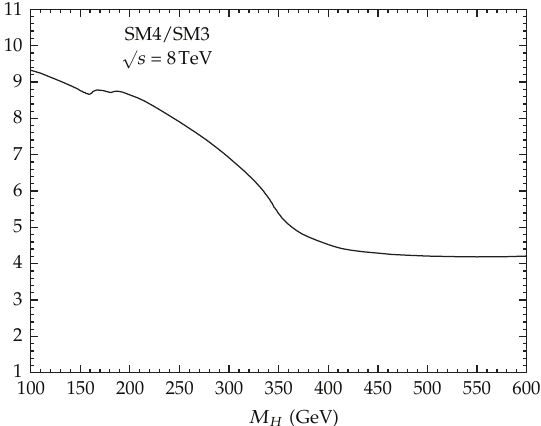
Figure 5: Comparison of gluon fusion cross-section within the SM4 and the standard model. Depending on the value of the Higgs mass sizeable deviations of the naive expectation for ratio to be nine is possible. For Higgs masses in the region of 125 GeV this expectation works, however, very well. Figure from [16].